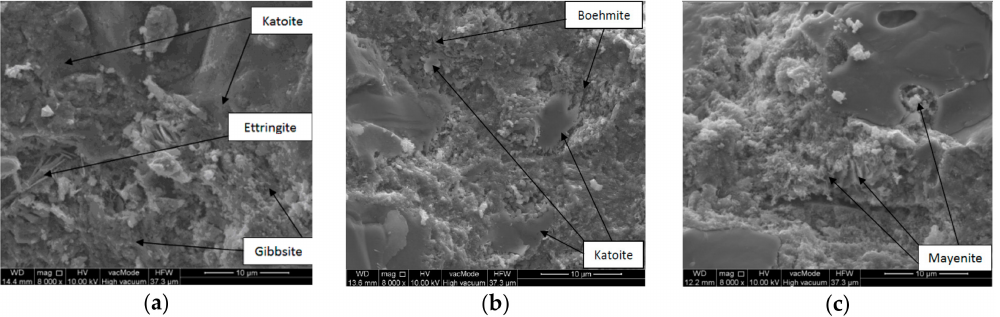
Figure 7. SEM micrograph of sample: ( a ) C10_20, ( b ) C10_400, ( c )